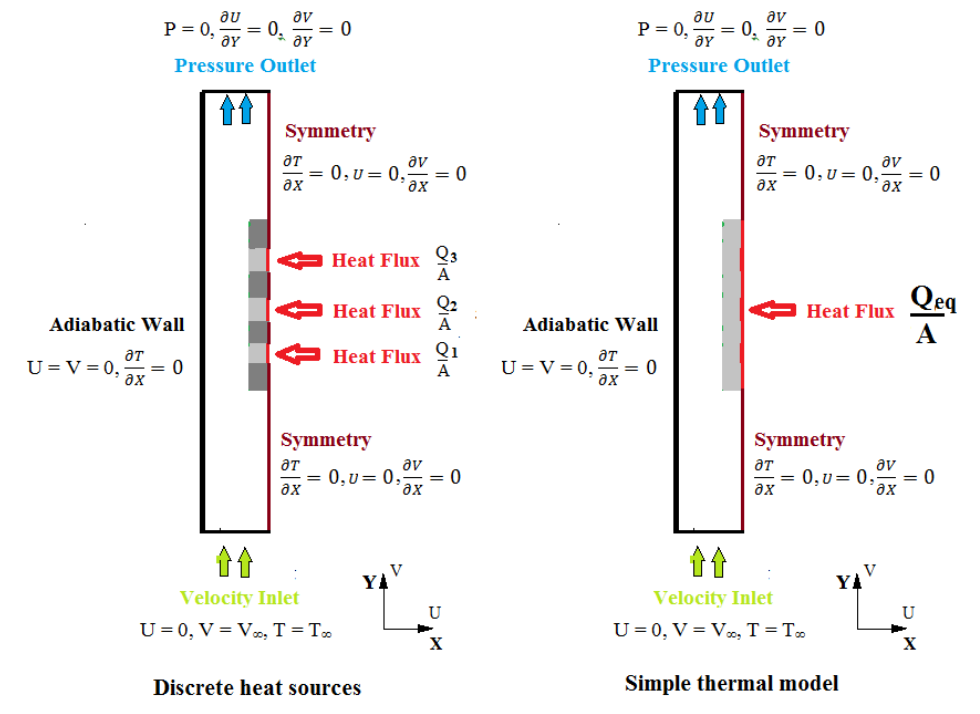
Figure 2. Boundary conditions on the computational